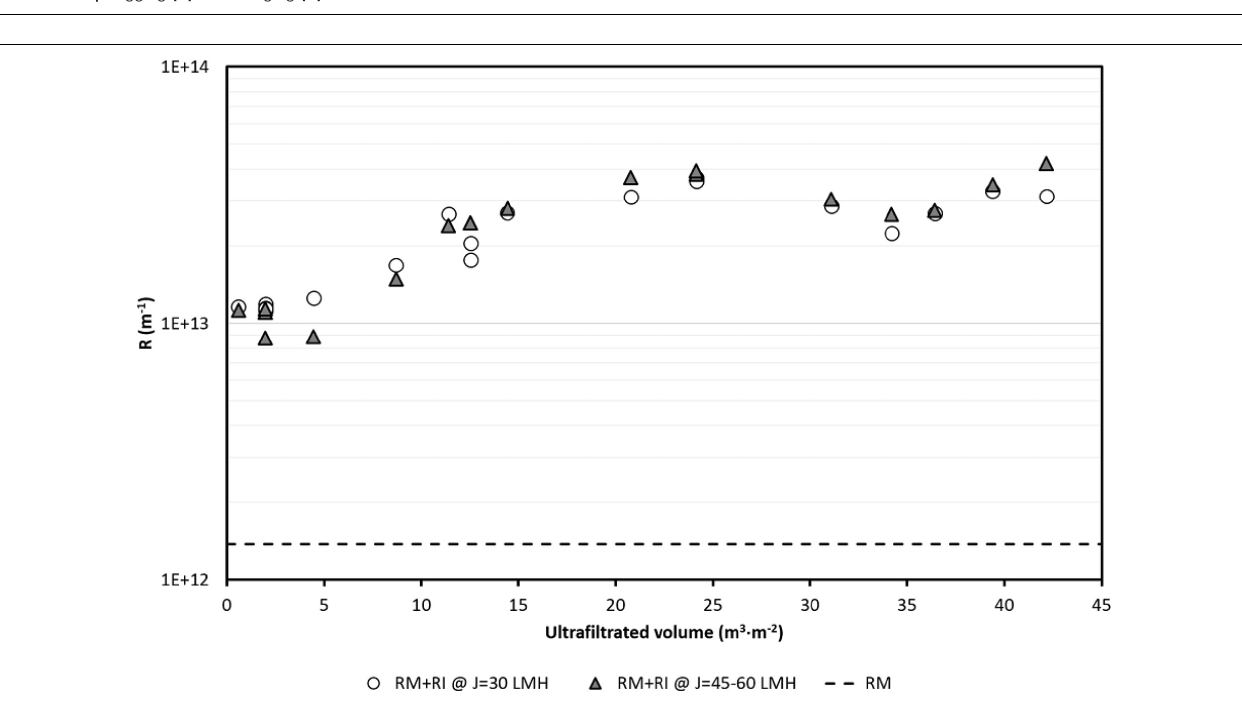
FIGURE 8 | Ragging (A) and sludging (B) observed on the external ultrafiltration membranes.